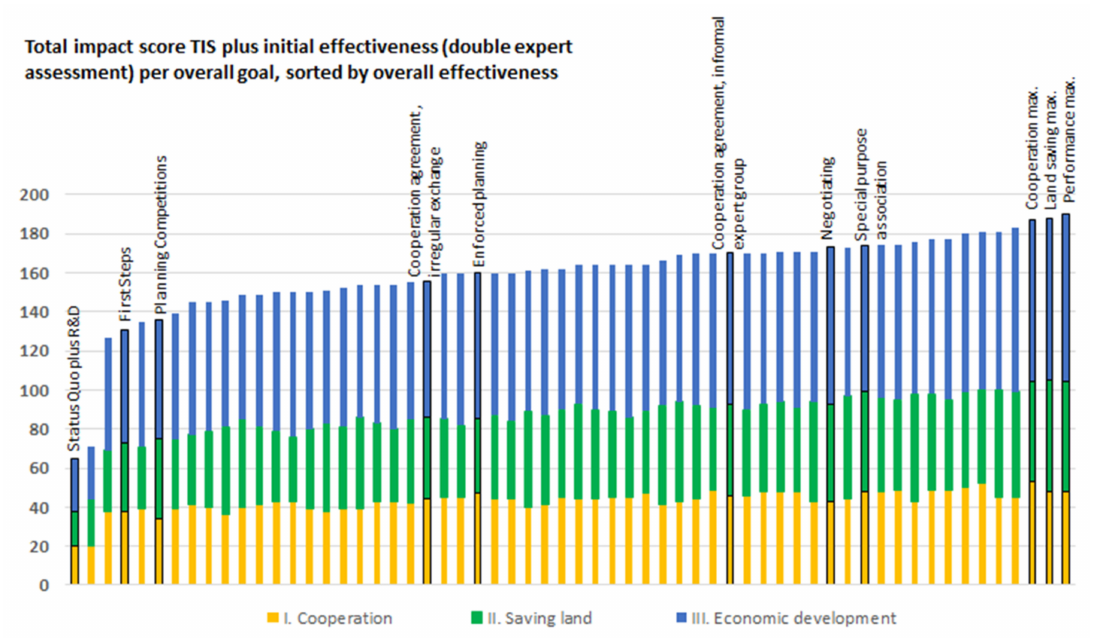
Figure 5. Goal attainment of consistent mixes: How well do the different mixes achieve the three overall